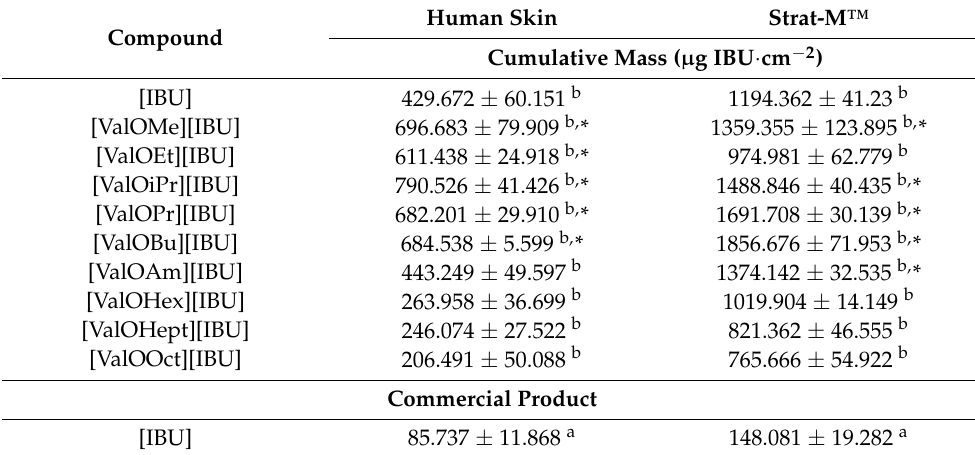
Table 2. The average cumulative mass of [IBU] and its modification after 24 h permeation test from the Celugel ® and commercial product across human SC and Strat-M™.